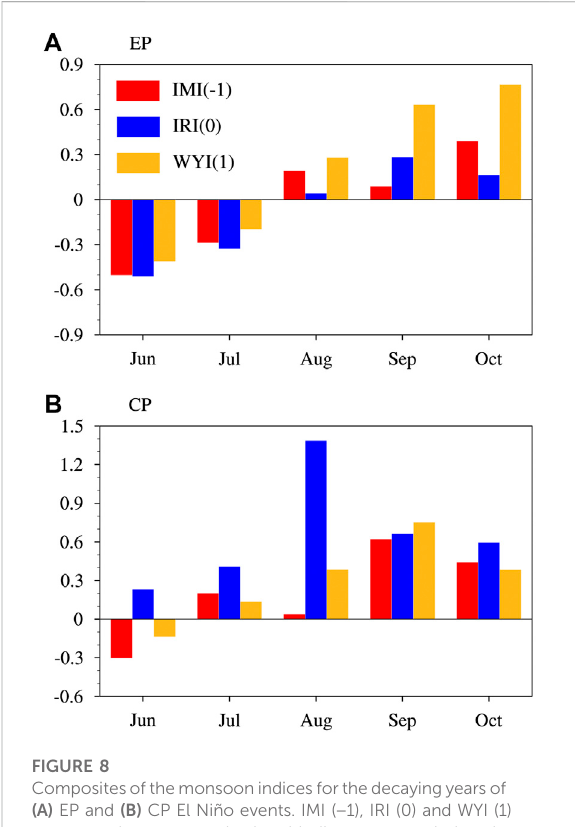
FIGURE 8 Compositesofthemonsoonindicesforthedecayingyearsof (A) EP and (B) CP El Niño events. IMI ( − 1), IRI (0) and WYI (1) represent the one-month-ahead Indian monsoon index, the simultaneous Indian rainfall index and the one-month- behind Webster – Yang index,